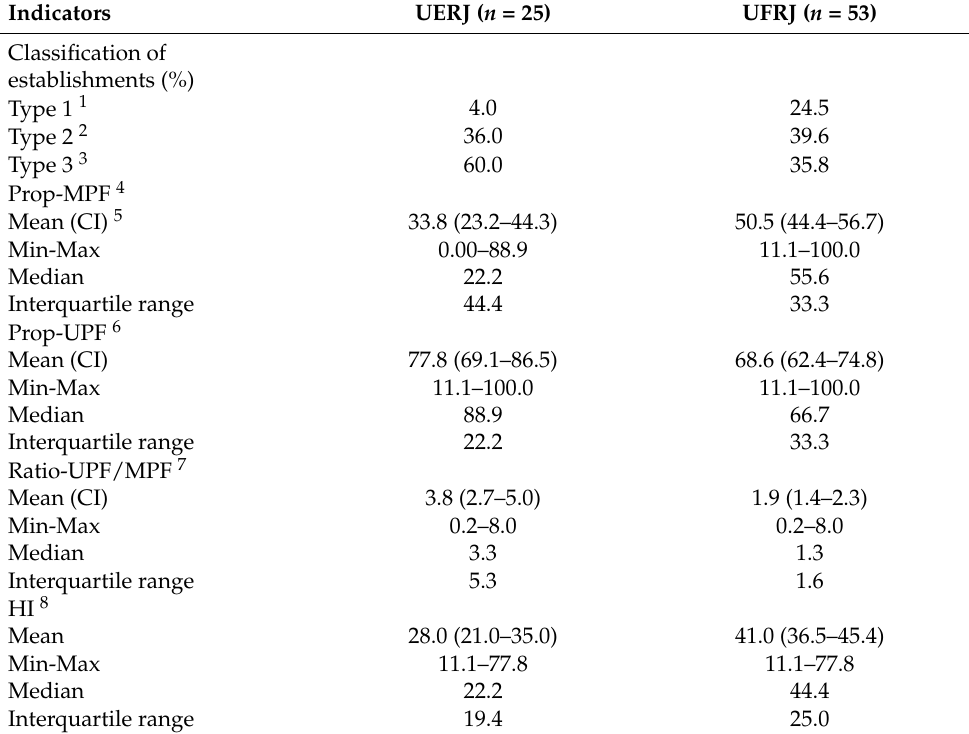
Table 3. Application of a priori classification of establishments and indicators of availability of foods for immediate consumption in establishments in two public universities, Rio de Janeiro, Brazil,